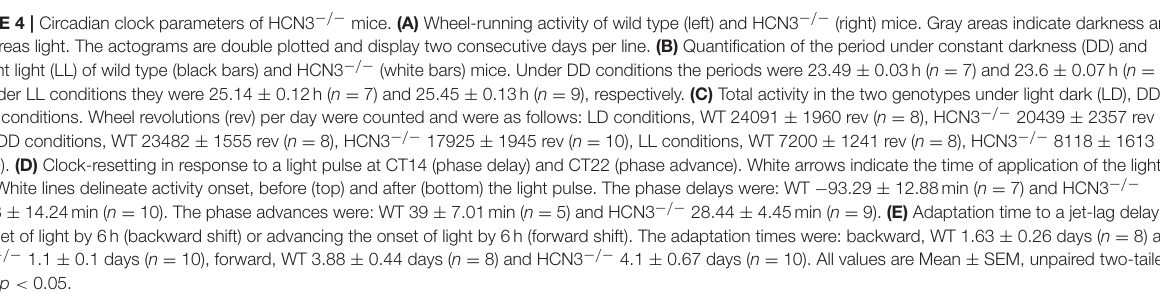
FIGURE 4 | Circadian clock parameters of HCN3 − / − mice. (A) Wheel-running activity of wild type (left) and HCN3 − / − (right) mice. Gray areas indicate darkness and white areas light. The actograms are double plotted and display two consecutive days per line. (B) Quantification of the period under constant darkness (DD) and constant light (LL) of wild type (black bars) and HCN3 − / − (white bars) mice. Under DD conditions the periods were 23.49 ± 0.03h ( n = 7) and 23.6 ± 0.07h ( n = 9) and under LL conditions they were 25.14 ± 0.12h ( n = 7) and 25.45 ± 0.13h ( n = 9), respectively. (C) Total activity in the two genotypes under light dark (LD), DD, and LL conditions. Wheel revolutions (rev) per day were counted and were as follows: LD conditions, WT 24091 ± 1960 rev ( n = 8), HCN3 − / − 20439 ± 2357 rev ( n = 10), DD conditions, WT 23482 ± 1555 rev ( n = 8), HCN3 − / − 17925 ± 1945 rev ( n = 10), LL conditions, WT 7200 ± 1241 rev ( n = 8), HCN3 − / − 8118 ± 1613